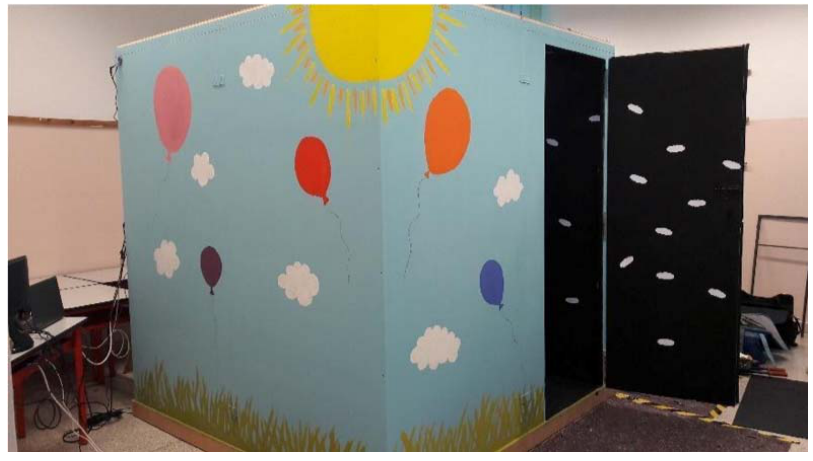
Figure 1. The testing room.